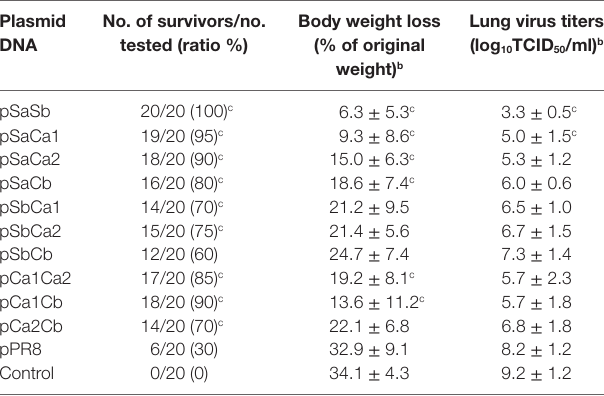
TaBle 3 | Protection against lethal virus challenge of mice immunized with plasmid DNAs substituted with two epitopes of the Pdm09 HA. a Plasmid no. of survivors/no. Dna tested (ratio